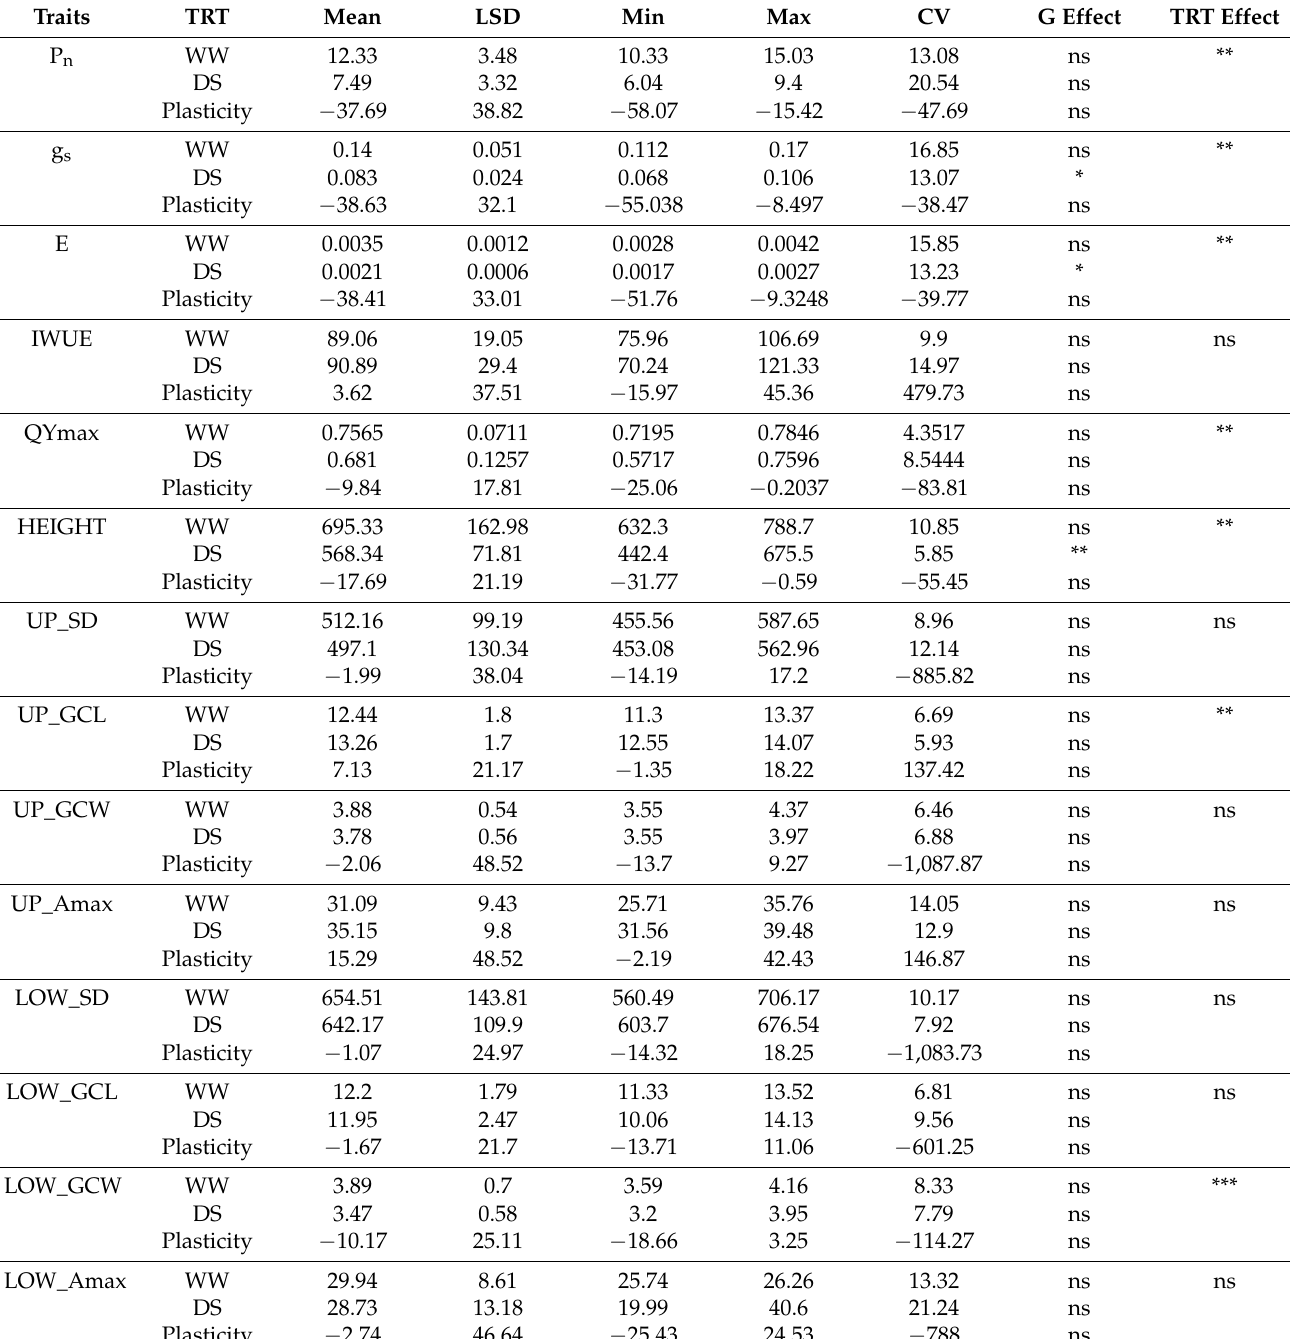
Table 1. Statistical summary and the effects of genotype (G effect), treatment (TRT effect) and plasticity on physiological and stomatal traits; well-watered (WW), drought stress (DS). The significance level is indicated as ‘*’ depending on p -values ( p < 0.05 ‘*’, p < 0.01